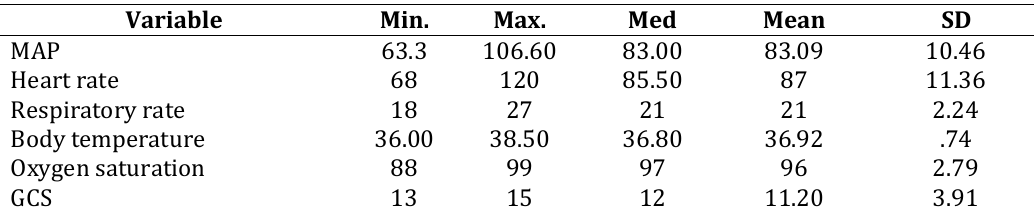
The values of hemodynamic status, oxygen saturation, and GCS Variable Min.